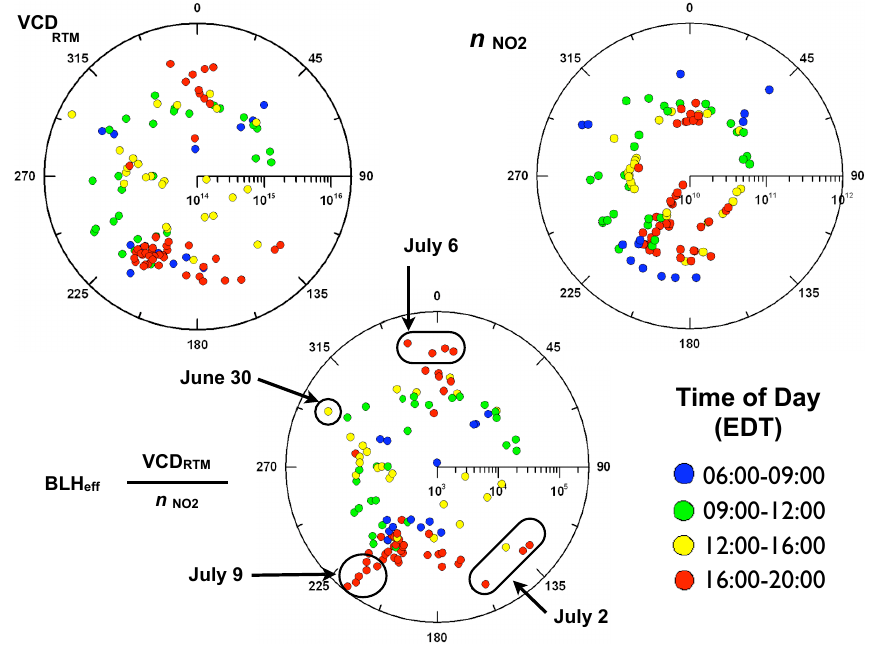
Fig. 12. Polar class scatter plot diagrams for Ridgetown. The NO 2 VCD RTM (moleccm − 2 ), the NO 2 number density (moleccm − 3 ), and the BLH eff (cm), are plotted on the radial axis vs. the wind direction, and are color-coded for the time of day of each measurement.